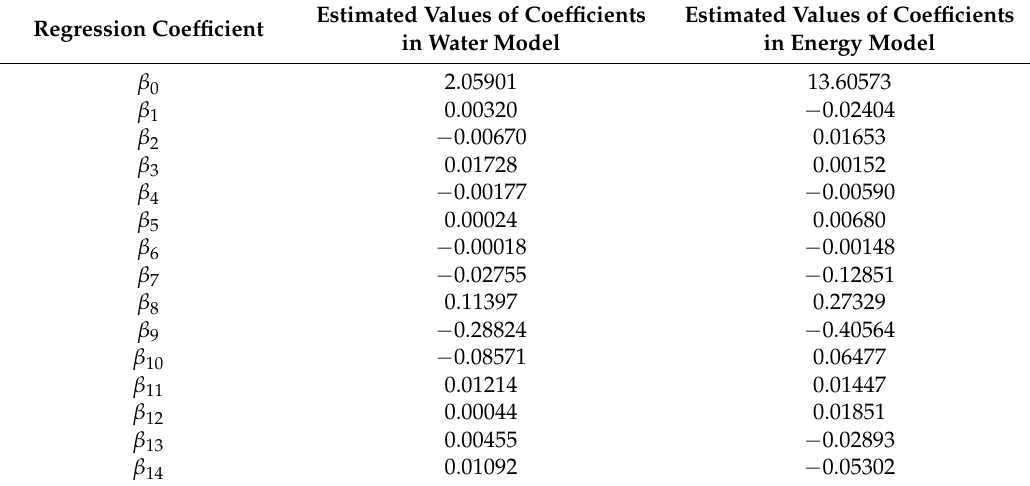
Table 3. Regression coefficients of the multiple linear regression (MLR)